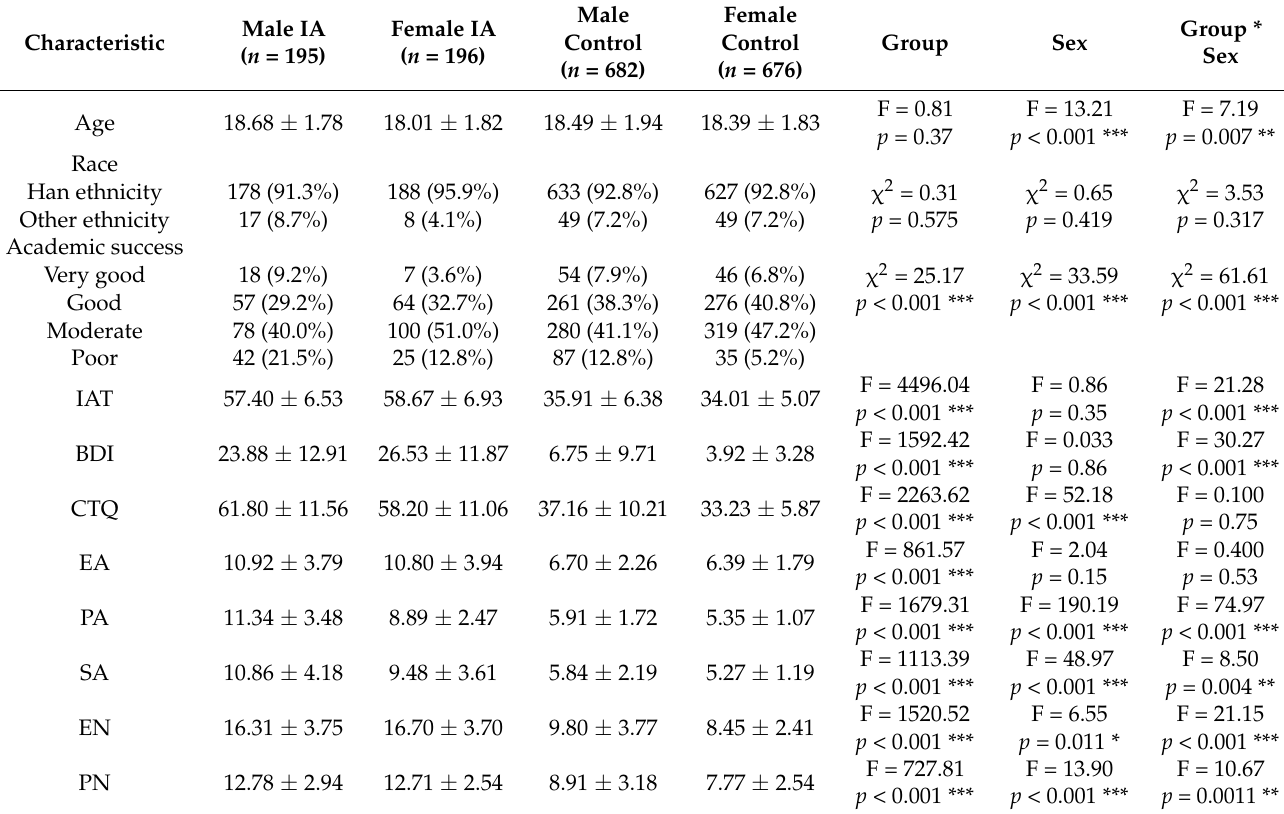
Figure 2. Mean and error bar (SD) plot of the BDI, IAT and CTQ totals and subscores shown separately for internet- addicted males, internet-addicted females, control males and control females. Significant group effects by sex interaction are represented by the cross lines between the internet–addicted males–control males and the internet–addicted females– control females. Table 1. Sociodemographic and clinical variables in the internet-addicted (IA) and control